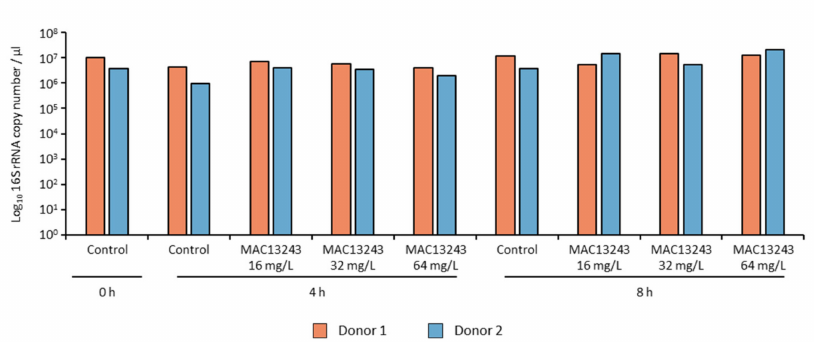
Figure 2. Quantification of total bacteria populations using qPCR of the 16S rRNA gene.